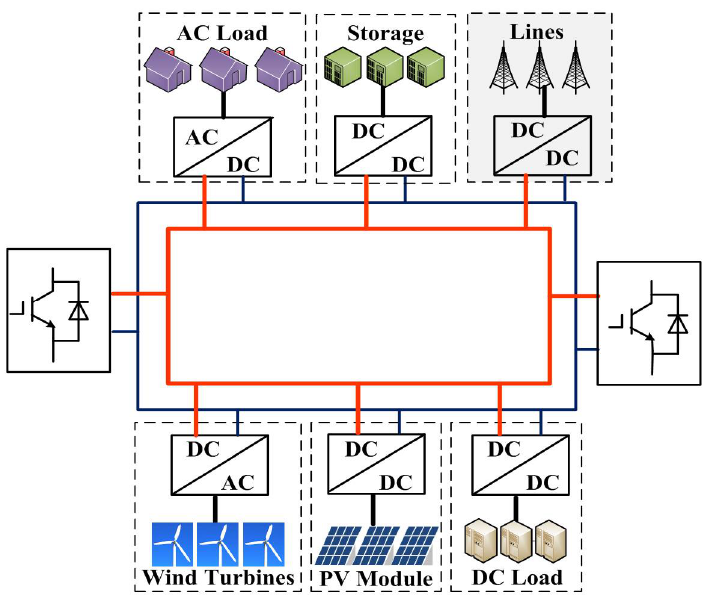
Figure 2. Ring structure of a multi-terminal DC microgrid.